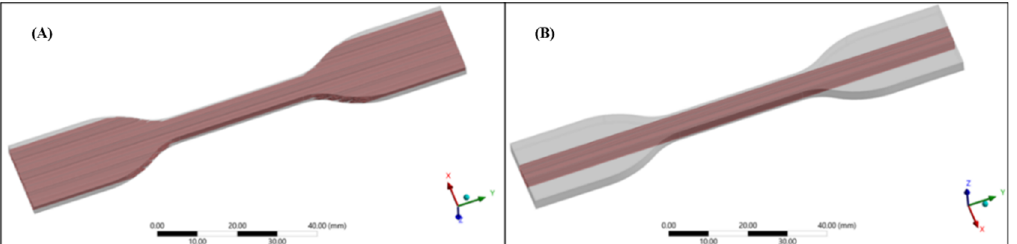
Figure 3. View of the dog-bone specimens used in Finite element analysis at Ansys structural environment. ( A ) Pattern configuration I fibers are uniformly distributed along the entire specimen’s volume ( B ) Pattern configuration II fibers are positioned only in the narrow cross-section of the